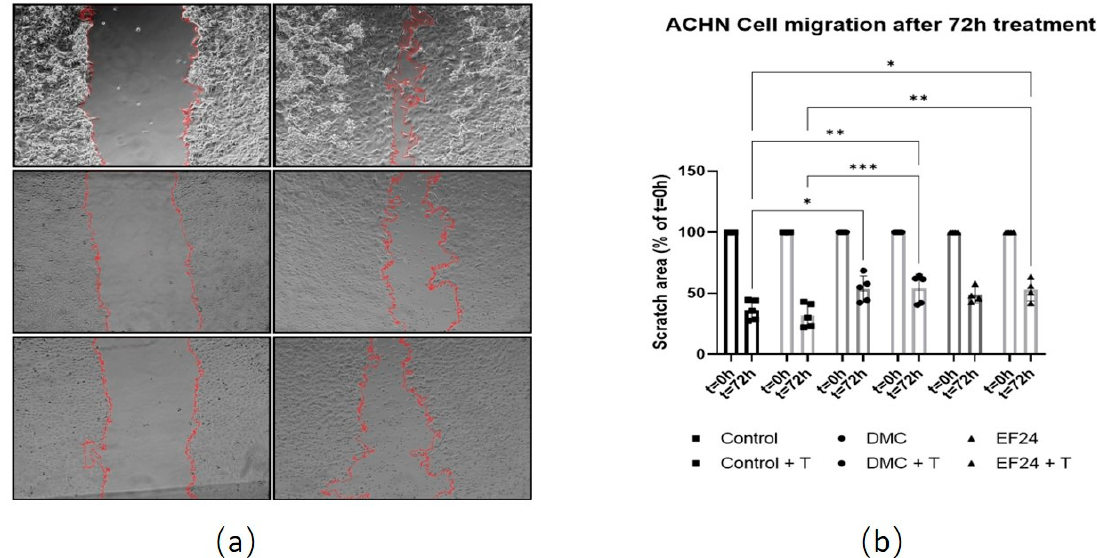
Figure 3. ACHN cell migration measured using a scratch assay at t = 0 h and t = 72 h of treatment using either DMC (10.94 µ M) or EF24 (21.36 µ M) in combination with TRAIL. ( a ) Scratch area (edges marked in red) at 0 and 72 h after treatment with DMC in combination with TRAIL and EF24 in combination with TRAIL. ( b ) ACHN cell migration decreases in presence of DMC and EF24 both individually and in combination with TRAIL. Combination treatment of DMC and TRAIL reduces scratch width to 54.11% after 72 h, whereas control cells reduce scratch width to 28.78%. Treatment with EF24 in combination with TRAIL reduces scratch width to 53.05%. Results shown are an average of 4 independent experiments. * p ≤ 0.05, ** p ≤ 0.01, *** p ≤ 0.001. Images analyzed using ImageJ [34].